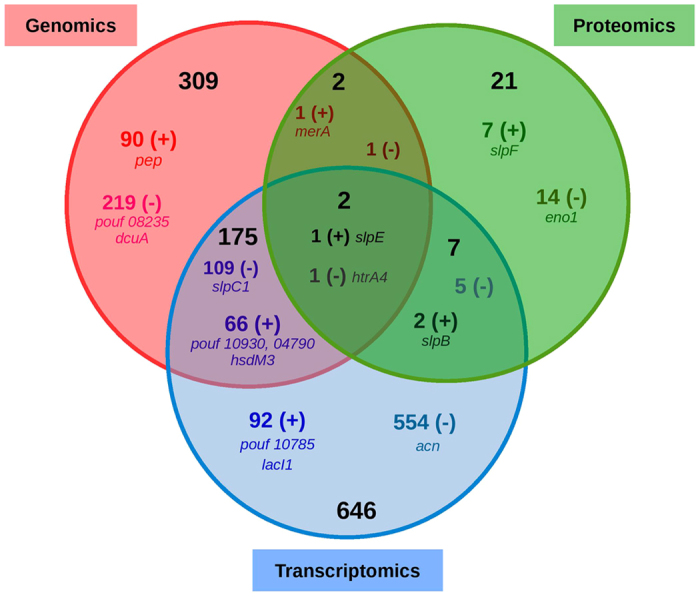
Venn diagram of Propionibacterium freudenreichii candidate genes identified as potentially being associated with anti-inflammatory properties, using omics methods (genomics, transcriptomics and surface proteomics).The numbers of candidates are those for which the regression model provides an adjusted p-value < 0.05 for the association. The regression model also provides a sign (+) or (−) corresponding to positive and negative associations with the induction of IL-10. (+) clusters are associated with IL-10 induction by anti-inflammatory strains whereas the reverse is true for (−) clusters. The names of the genes are specified for those mentioned in the text of the publication and in Table 1.